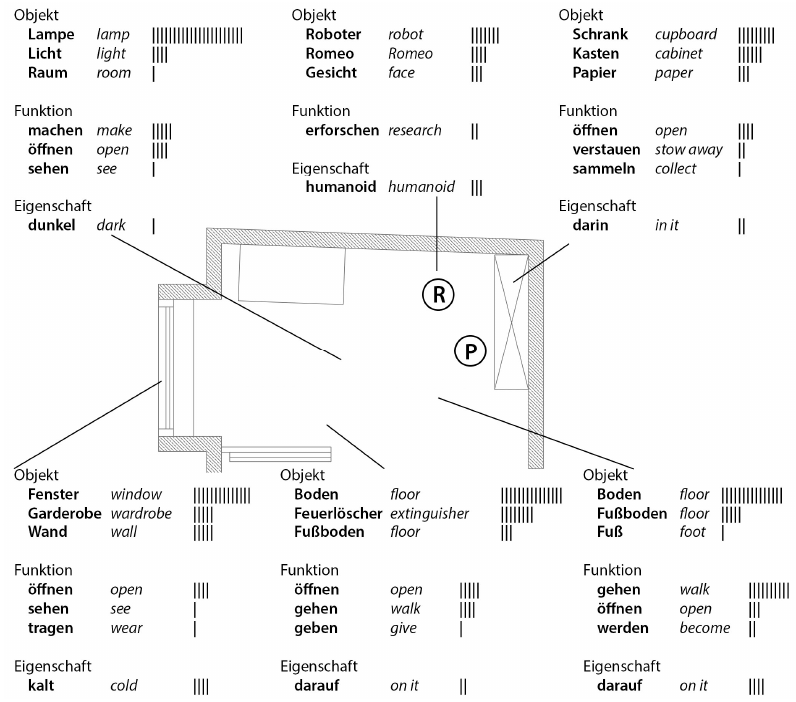
Figure 2. Floor plan of the experimental area with the location of the six objects, translated into English: the robot (R) and the interview partner (P). Naming of object, function attributed to object, property associated to function and object. Bars indicate how often names and functions were mentioned.